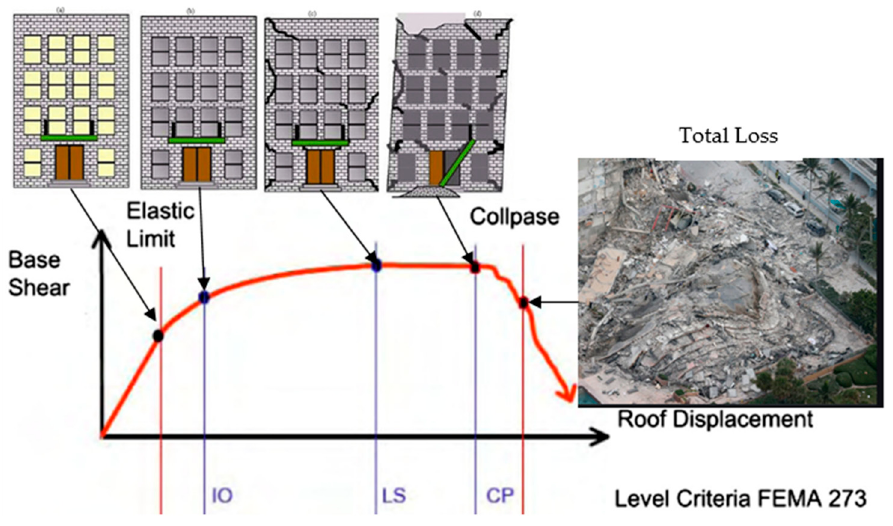
Figure 2. Graph of building response to member response.